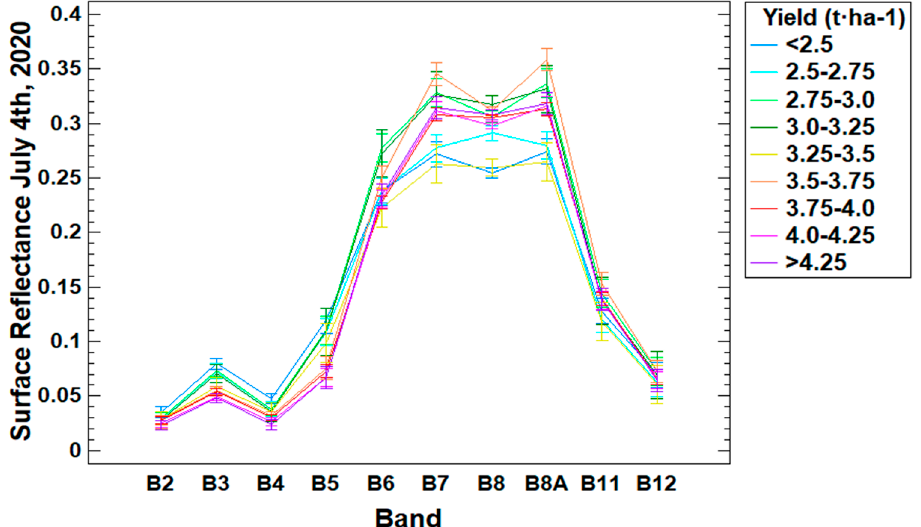
Figure 5. Surface reflectance average values for each Sentinel-2 band grouping all pixels of the Bomba